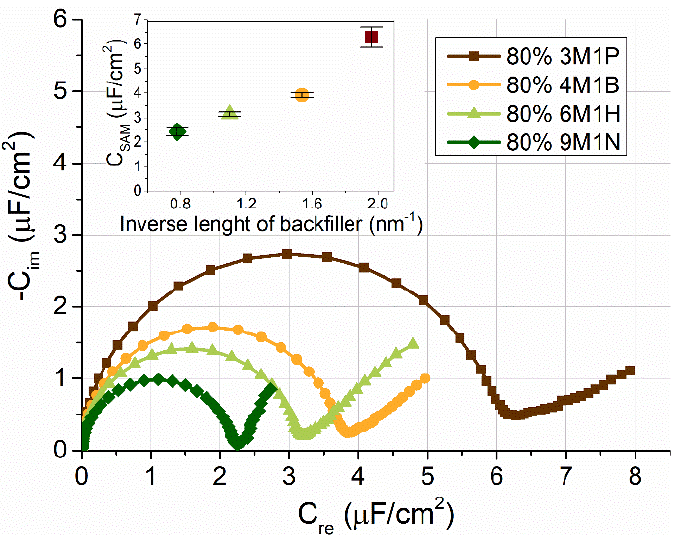
Figure 6. Representative EIS spectra of mixed WC14/backfiller (in ratio 20:80%) SAMs containing different backfillers: 3M1P, 4M1B, 6M1H, and 9M1N. The Cole–Cole complex capacitance plots; Inset demonstrates capacitance values of different-backfiller SAMs as a function of backfiller length (nm − 1 ). Frequency range 100 kHz–0.1